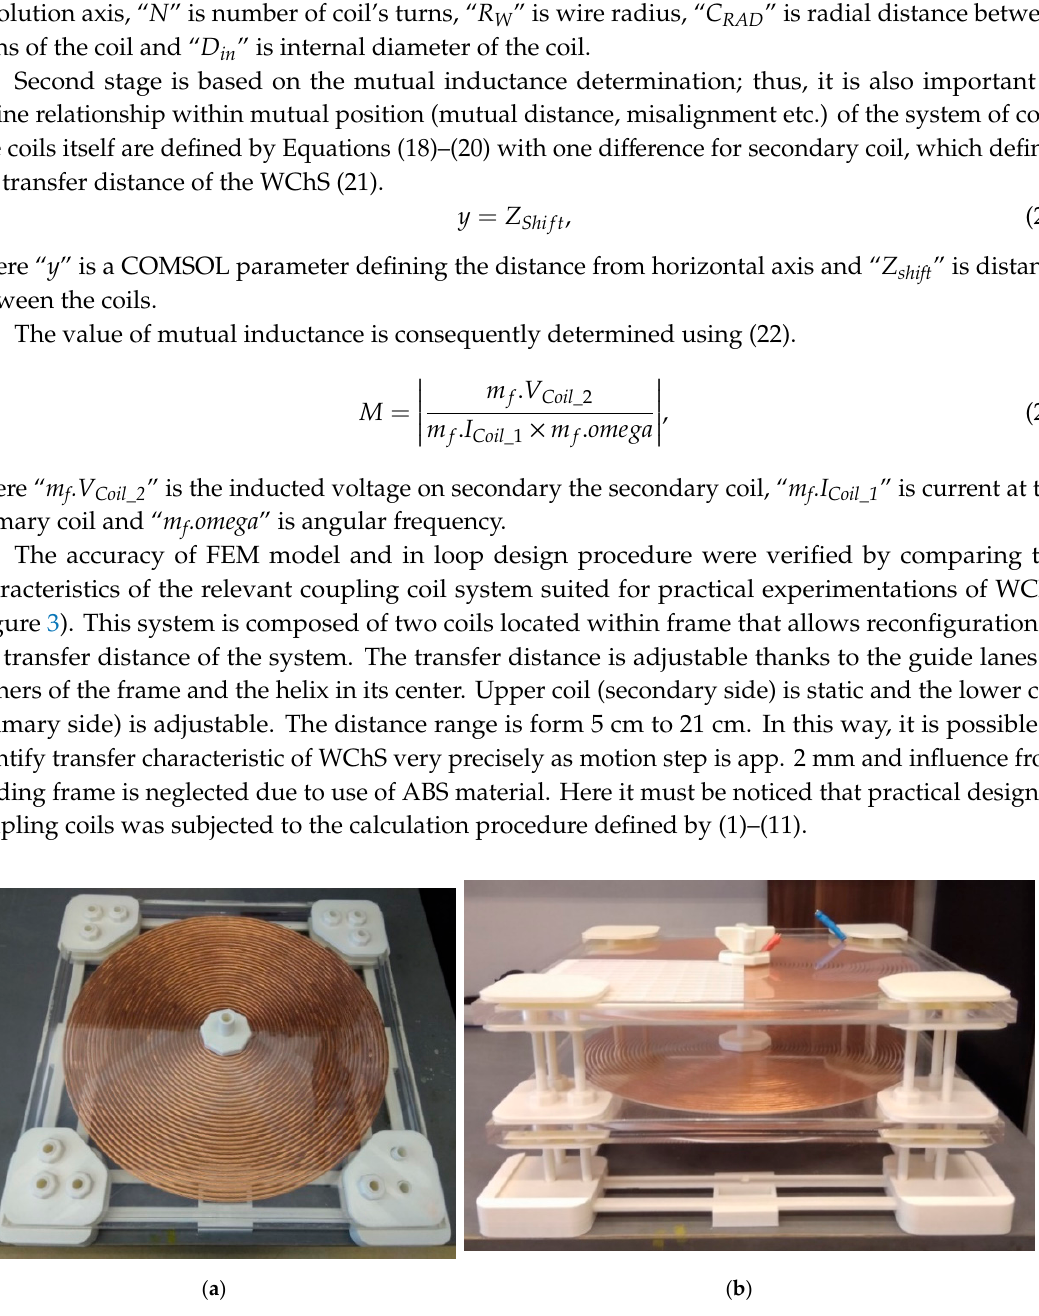
Table 2. Geometry parameters of Non-Shielded Coils for model verification.